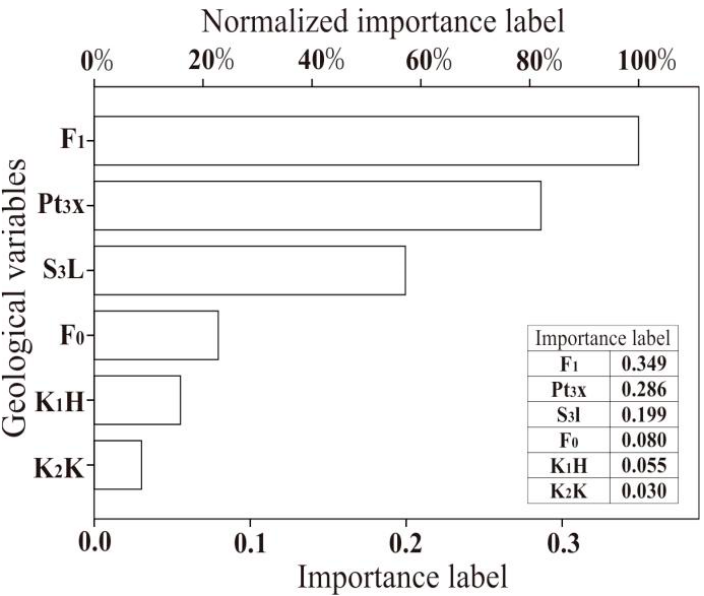
Figure 6. Evaluation results of geological variables by artificial neural network method.